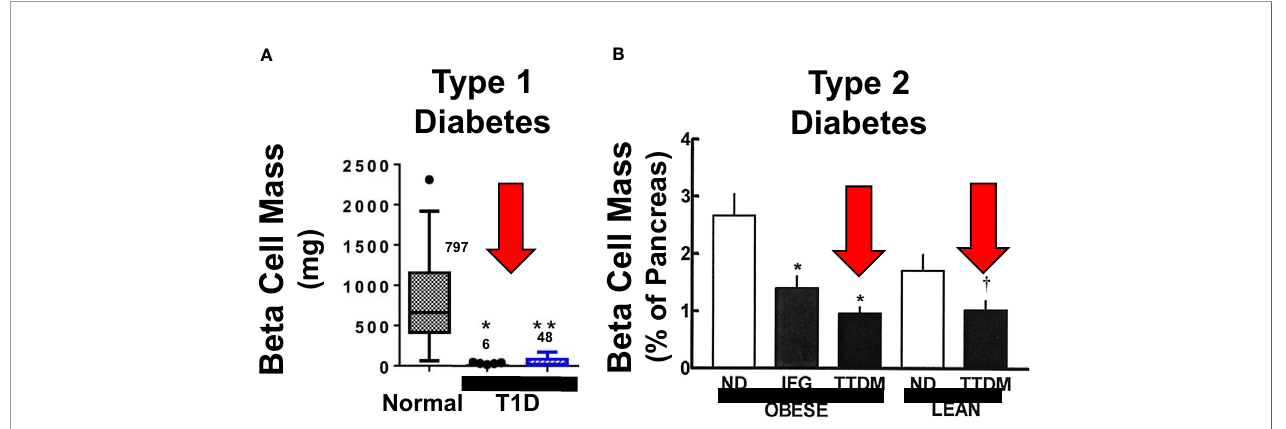
FIGURE 1 | Beta Cell Mass in Type 1 and Type 2 Diabetes. (A, B) display beta cell mass assessed at autopsy in people with longstanding Type 1 diabetes (T1D) and Type 2 diabetes (T2D or TTDM), and people with impaired fasting glucose (IFG), also called metabolic syndrome. The red arrows highlight the relative reduction in beta cell mass in both T1D and T2D as compared to age, BMI and sex matched normal. Importantly, beta cells persist, in reduced numbers, in people who have had both T1D and T2D for decades, indicating that most people in both groups have residual beta cells that can serve as substrates for beta cell regenerative drugs. Adapted with permission from (2, 7). (2, 4 – 6) and (3, 7 – 9) provide additional examples. (A) Is reprinted with permission from (7). * and ** both indicate p < 0.001 vs. controls. The numbers within the graph indicate beta cell mass, in mg, in the three groups. (B) is reprinted with permission from (2). * indicates P < 0.01 and † indicates p <